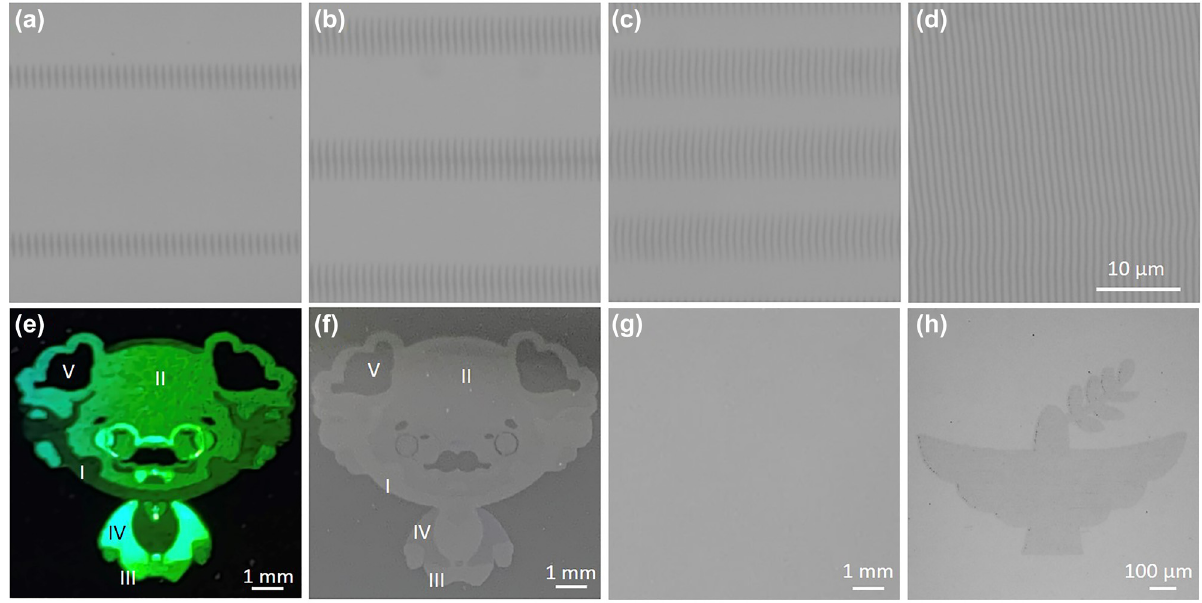
Figure 8: Multifunction and multilevel rewritable optical recording. (a)–(d) Optical microscopy images of line pixels with the pulse energy as 145.4, 117.2, 83.6 and 58.4 nJ, respectively, corresponding to regions I–IV in (e)–(g) written by the ps laser. (e) Five-brightness-level cartoon portrait of Albert Einstein captured by the camera under the illumination of strong light, and (f) depicts corresponding grayscale identification under natural light source. (g) Erased sample in crystalline phase state after thermal annealing. (h) Grayscale image rewritten by reamorphization.